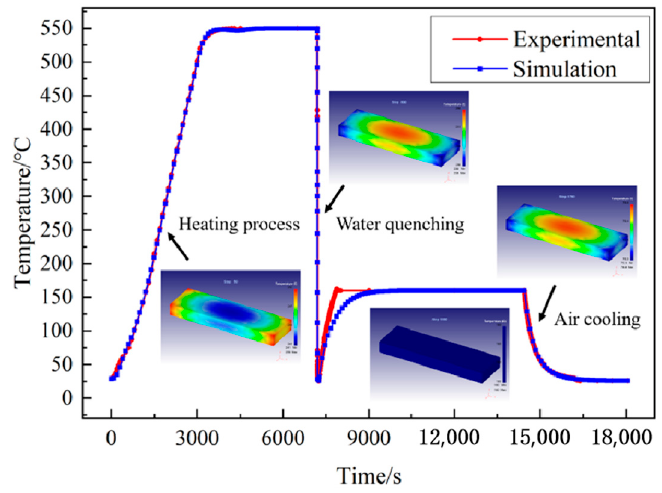
Figure 12. Comparison of the simulation and experimental temperatures in the heat treatment process.